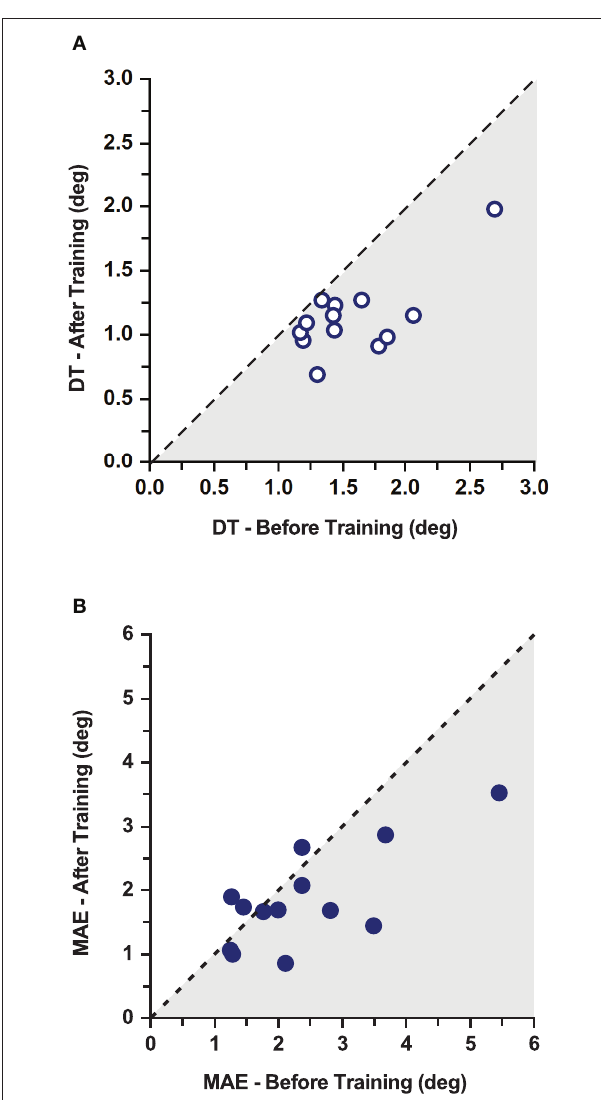
FIGURE 4 | Effects of training on discrimination thresholds and movement accuracy. (A) Mean proprioceptive discrimination thresholds (DT) before and after training across all the participants in the PD and healthy control group. (B) Mean Movement Accuracy Error (MAE) before and after training across all the participants in both the PD and the healthy control